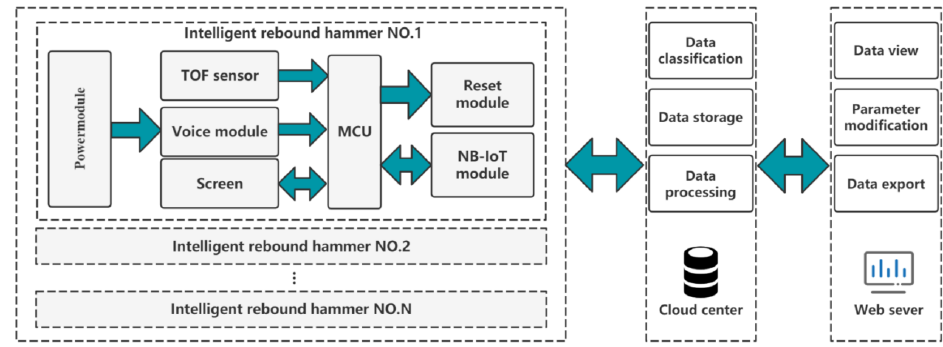
Figure 1. The schematic diagram of system